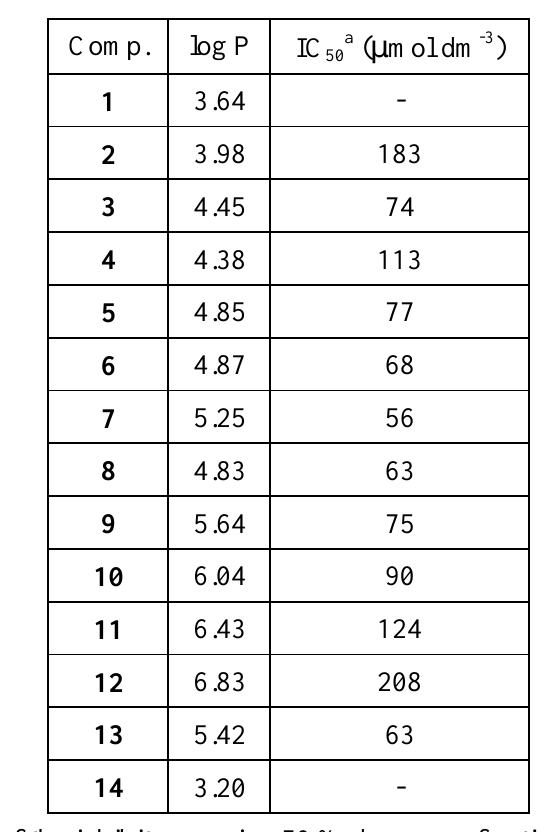
Table 2. Experimental values of IC of the studied compounds concerning oxygen evolution rate 50 inhibition in spinach chloroplasts and calculated log